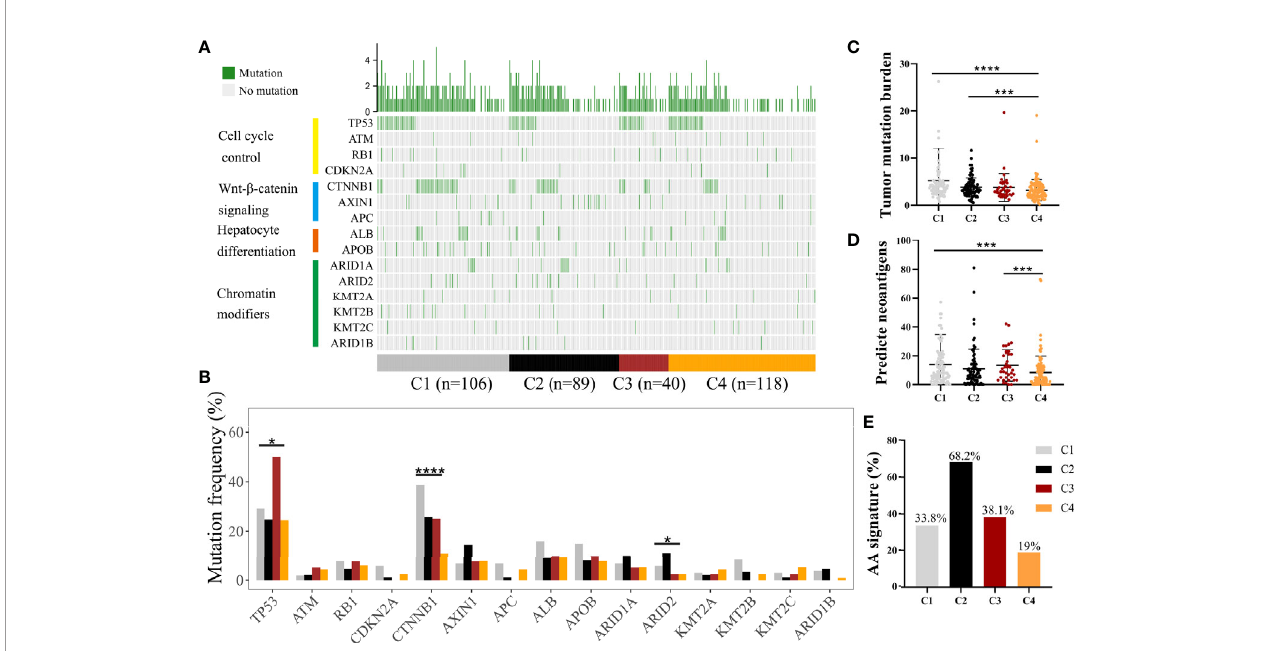
FIGURE 3 | Differences in the mutational landscape among distinct immune subclasses. (A) Oncoplot of tumor somatic mutation of genes in P53 pathway, Wnt/ beta-catenin pathway, Chromatin modi fi ers pathway and hepatic differentiation based on TCGA cohort. (B) Comparisons of the frequently mutated genes among four immune subclasses based on TCGA cohort. (Fisher ’ s exact test). Comparison of tumor mutation burden (C) and predicted neoantigens (D) among four immune subclasses. (Wilcoxon rank sum test). (E) The proportion of patients with AA signature among distinct subclasses in CHCC-HBV cohort. *P < 0.05, **P < 0.01, ***P < 0.001, ****P <